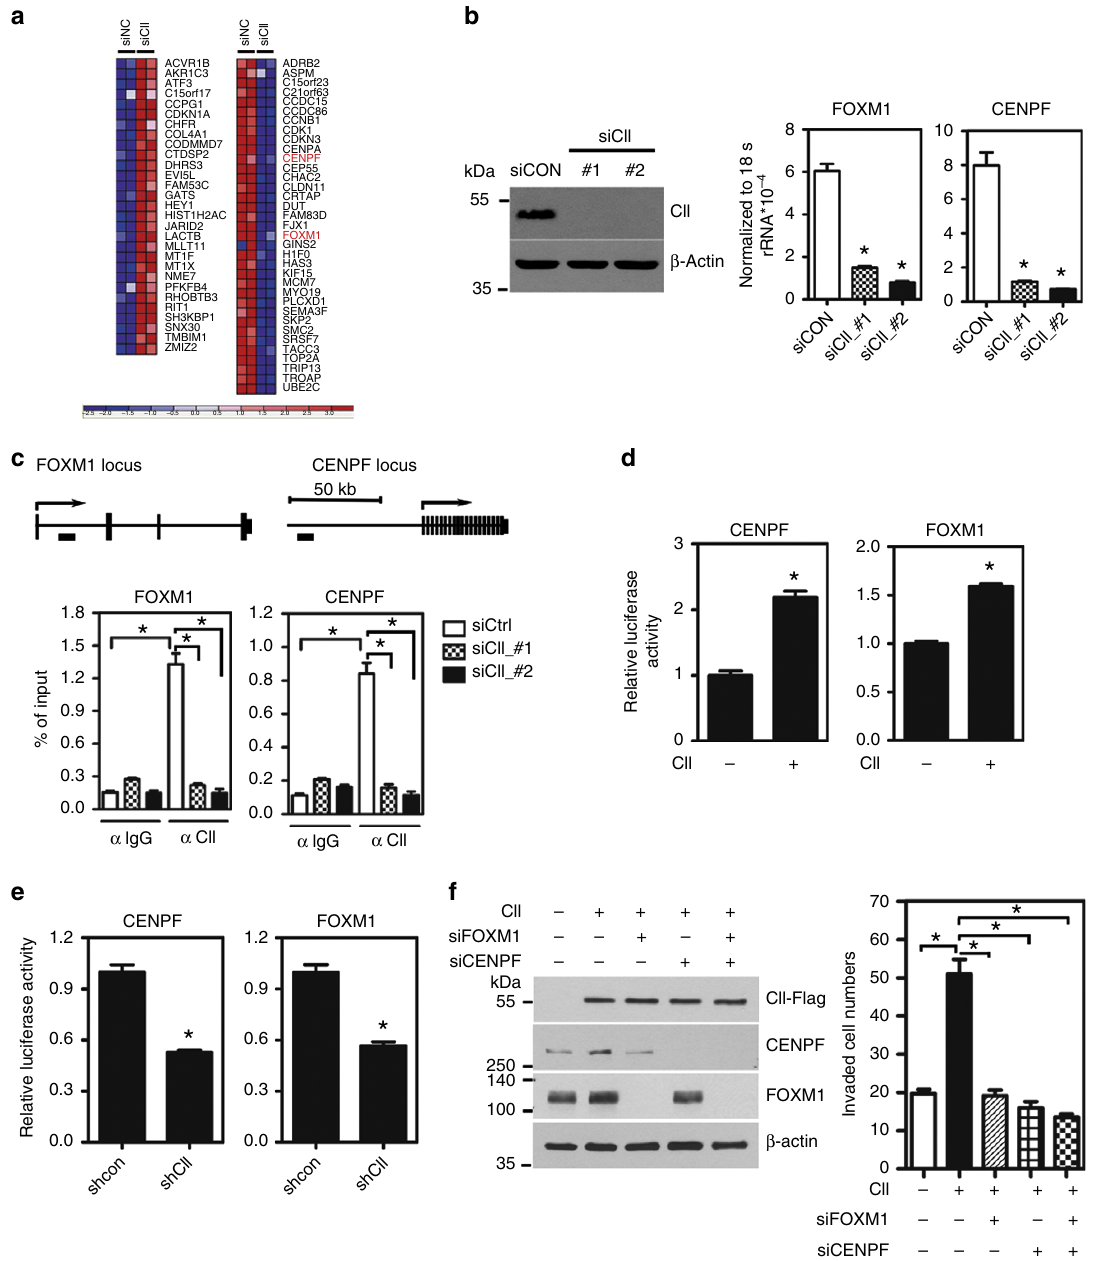
Figure 4 | FOXM1 and CENPF are downstream targets of COUP-TFII in PCa. ( a ) Gene expression profile of COUP-TFII knockdown PC3 cells (GSE33182) was downloaded from GEO database and analysed using GenePattern. Genes with P o 0.05, FOLD CHANGE 4 1.5-fold are represented as a heatmap. The gene symbol of FOXM1 and CENPF genes after knockdown of COUP-TFII are annotated in red colour. The others were FOXM1 and CENPF co-regulated genes annotated in black colour. siCtrl: knockdown scramble control; siCII: knockdown of COUP-TFII. ( b ) A representative western blot shows the level of COUP-TFII in PC3 cells transfected with two different siRNAs against COUP-TFII for 72h (upper panel). Levels of FOXM1 and CENPF are quantified by RT- qPCR (lower panel) ( n ¼ 3). * P o 0.05 (two-sided Student’s t -test) compared with the control group (siCON). ( c ) A cartoon shows the FOXM1 and CENPF loci. COUP-TFII-binding sites are annotated by a black rectangle (upper panel). ChIP results are shown in the PC3 cells treated with control and two different siRNAs against COUP-TFII for 72h (lower panel) ( n ¼ 3). * P o 0.05 (two-sided Student’s t -test) compared with control. ( d ) FOXM1 and CENPF promoter activities were measured in PC3 cells carrying an inducible COUP-TFII gene in the absence or the presence of doxycycline for 48h ( n ¼ 3). * P o 0.05 (two-sided Student’s t -test). ( e ) FOXM1 and CENPF promoter activities were measured in control or stably knocked-down COUP-TFII in PC3 cells for 48h ( n ¼ 3). * P o 0.05 (two-sided Student’s t -test). ( f ) PC3 cells carrying with inducible COUP-TFII-Flag gene were treated with or without doxycycline for 48h and then transfected with individual siRNA against FOXM1 and CENPF or double knockdown of FOXM1 and CENPF for an additional 48h. western blot (left panel) shows the level of COUP-TFII, CENPF and FOXM1 expression. Invasion assay (right panel) was performed by using those cells ( n ¼ 3). * P o 0.05 (two-sided Student’s t -test) compared with